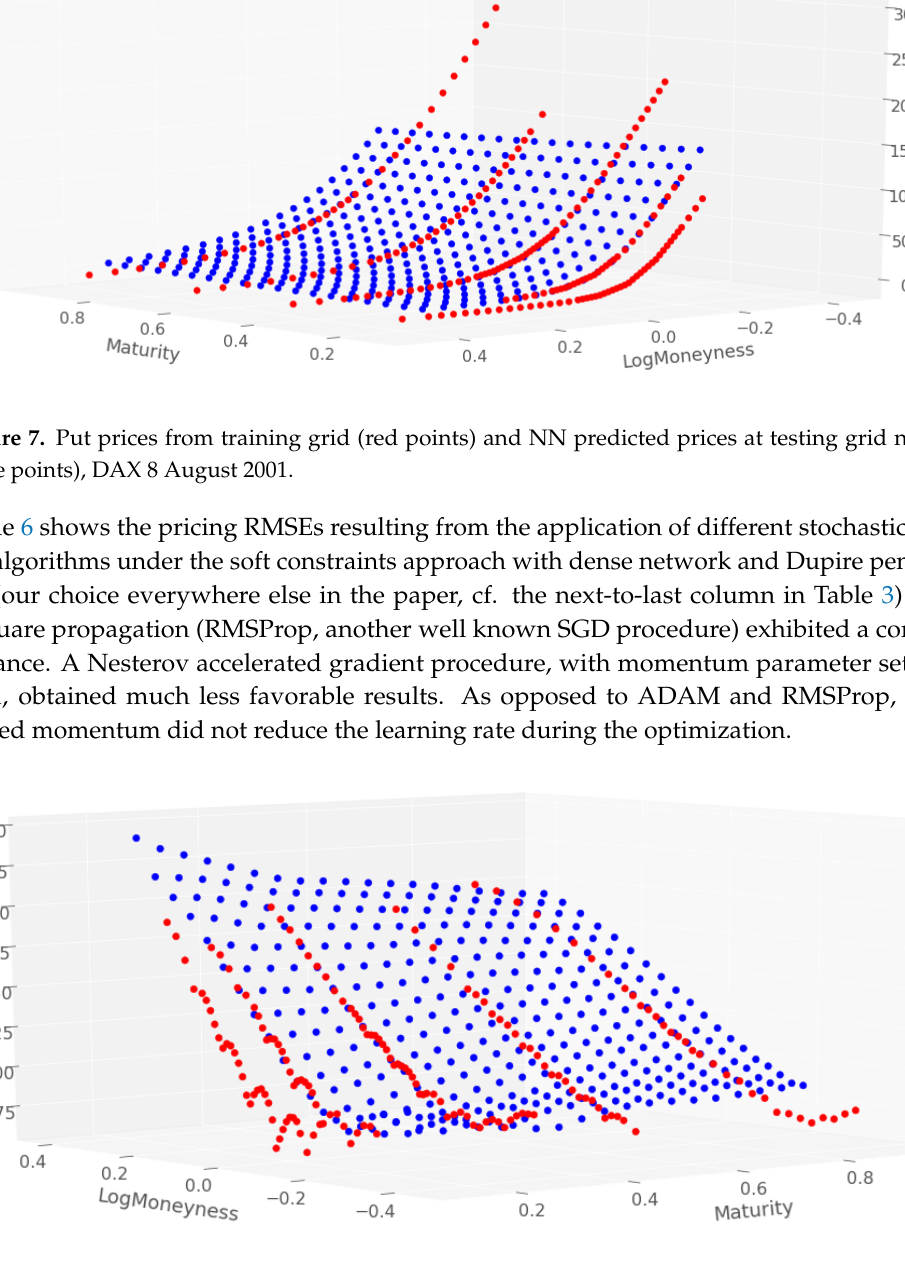
Figure 8. Same as Figure 7 in implied volatility